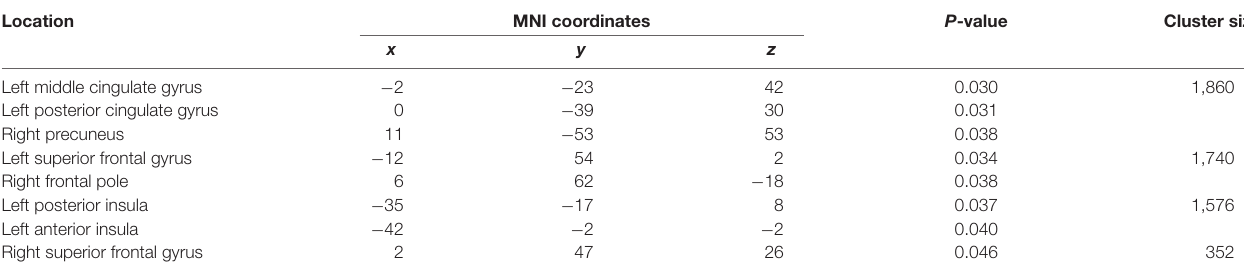
TABLE 4 | Brain areas with significantly larger gray matter volume in athletes than in non-athletes (TFCE analysis, P < 0.05, FWE corrected).